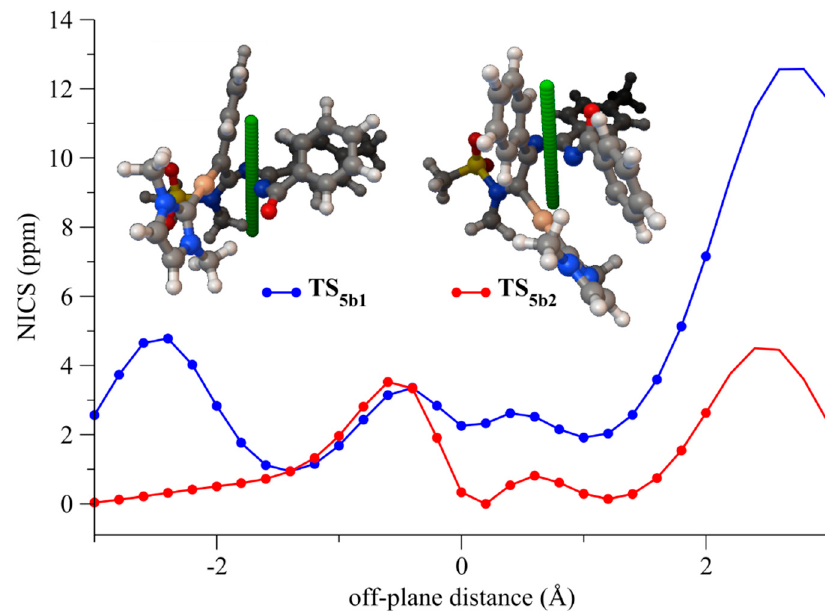
Figure 1. Nucleus-independent chemical shifts computed at the M06/Def2SVPP level for TS 5b1 and TS 5b2 .